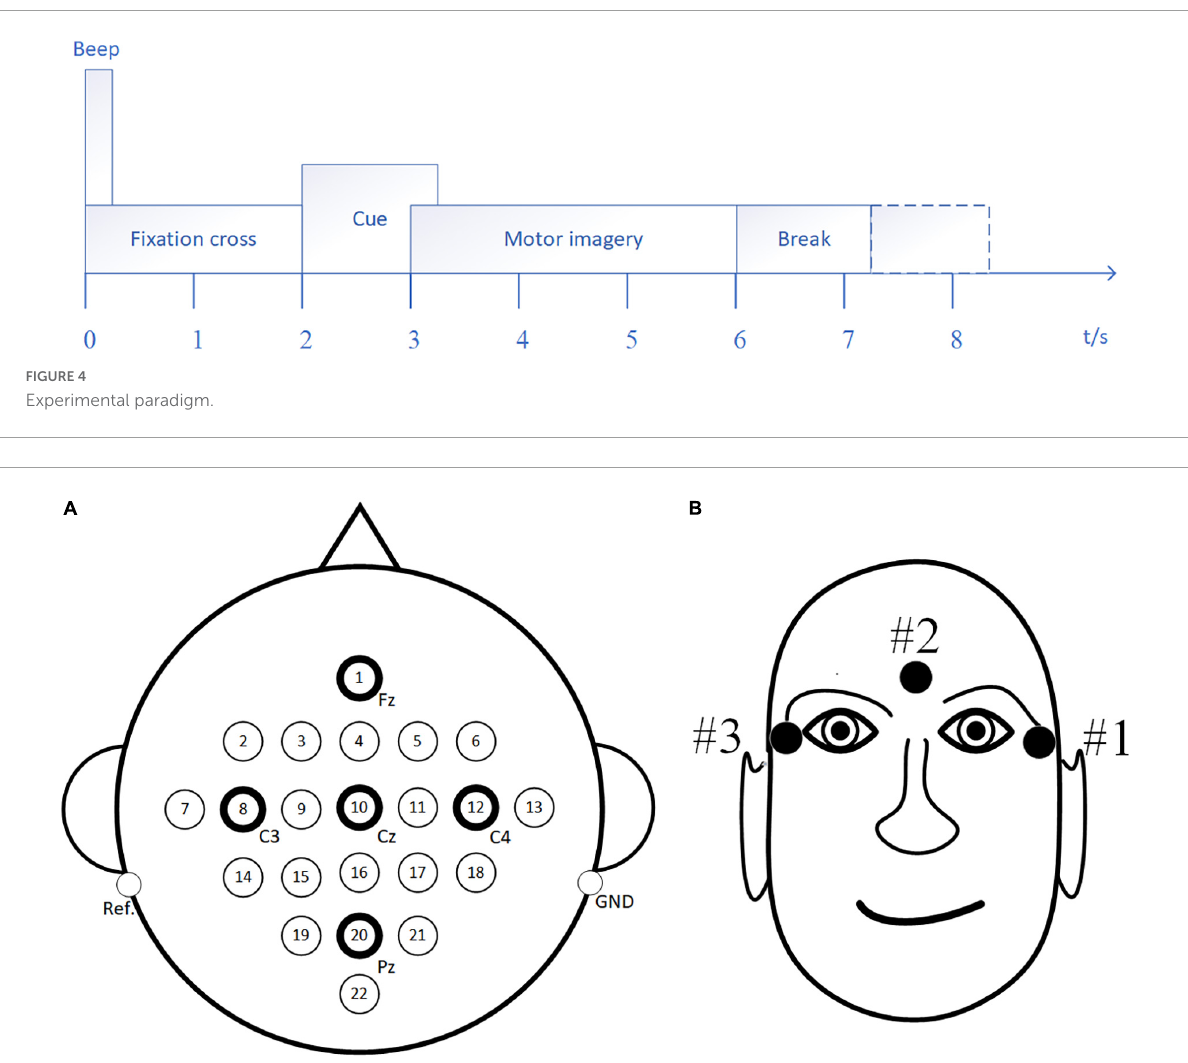
FIGURE5 The position of electrode. (A) Electroencephalogram (EEG) electrode position (B) EOG electrode